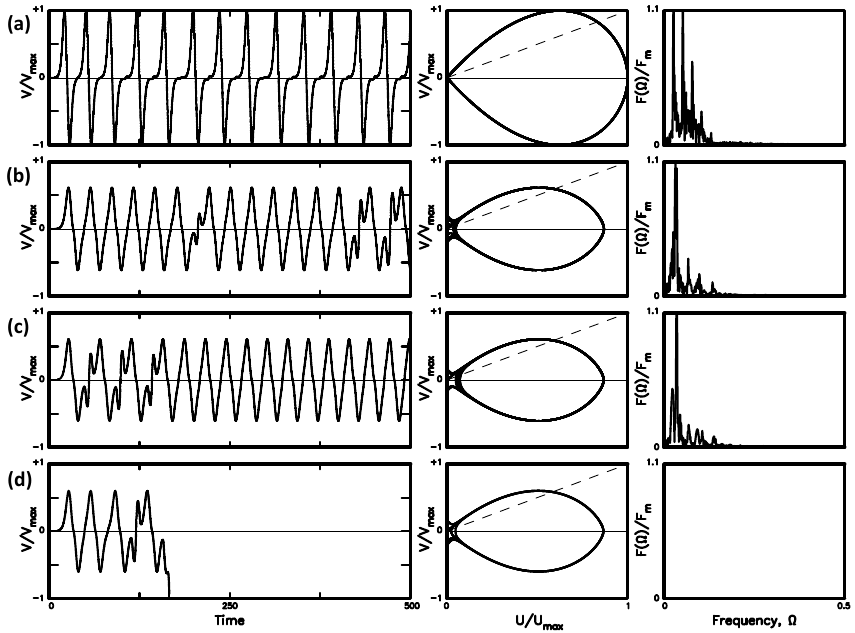
Figure 10. The time variation in V/V max , the phase portrait of V/V max versus U/U max , and the power spectrum for four values of η : (a) for η = 0 . 34; (b) for η = 0 . 71; (c) for η = 0 . 72; and (d) for η = 0 . 73 when U c = 0 . 7 for the TP law of F(U) = exp ( − U/U c ) .